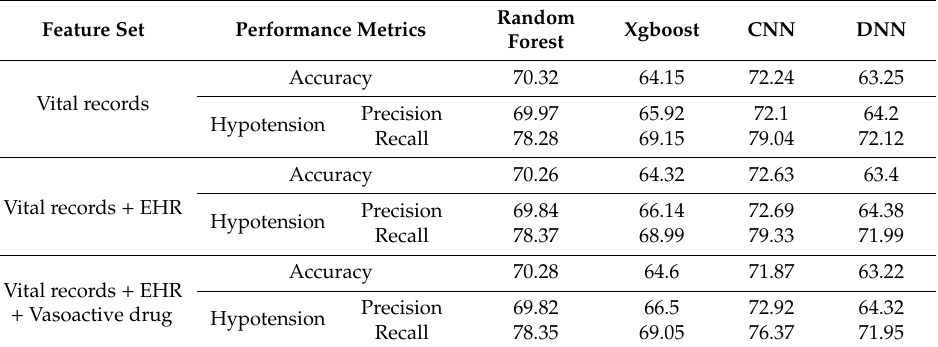
Table 5. Results on prediction performance using raw